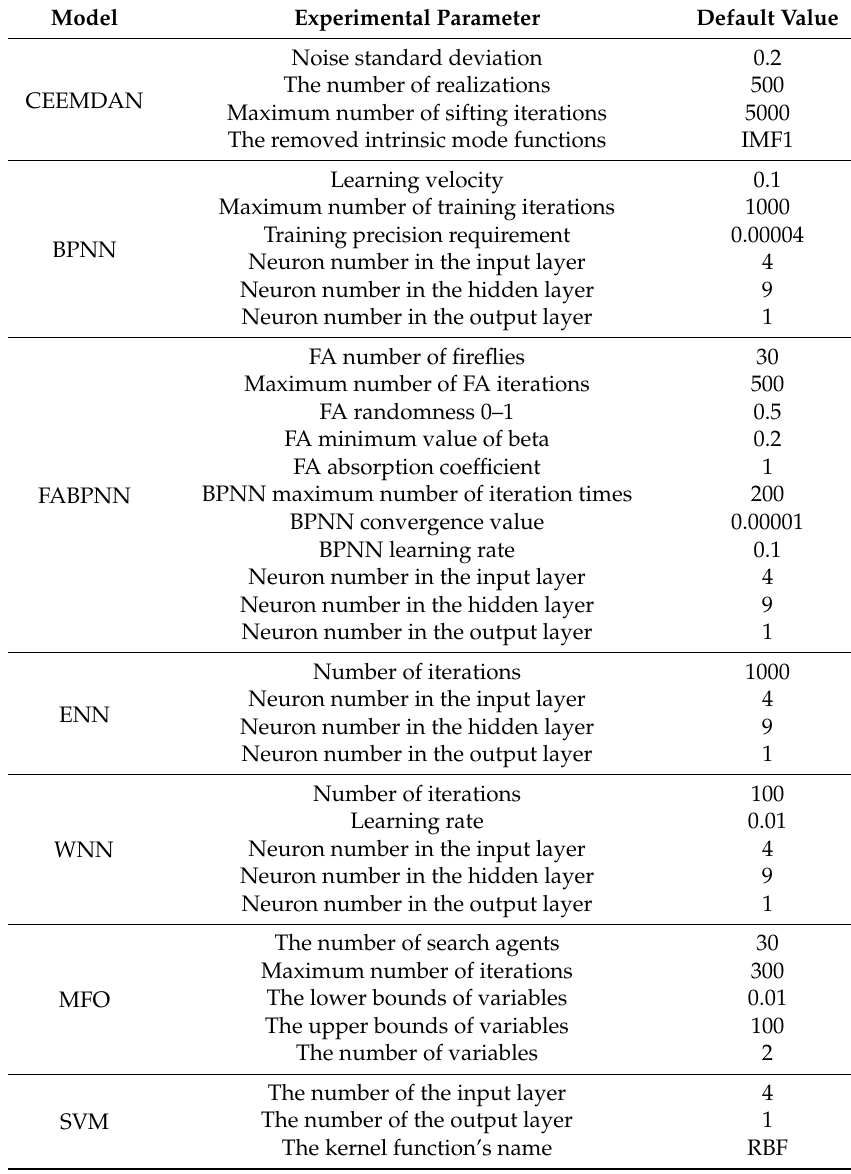
Table 2. Experimental parameter